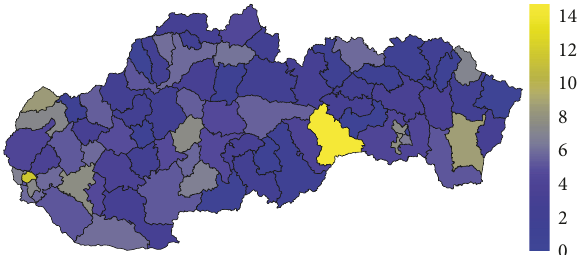
Figure2:Theaverageannualstandardisedmortalityrateofthemale sex in the individual districts of the Slovak Republic for the whole